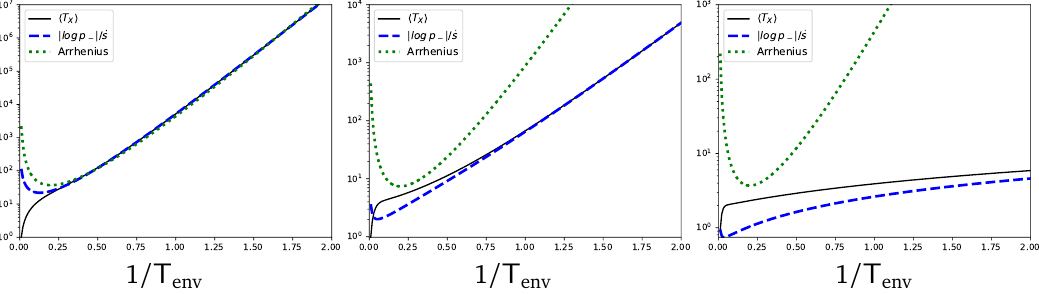
Figure 3: Asymptotic lower bound on the mean first-passage time. The ratio 〈 T 〉 ˙ s / | log p | is plotted as a function of (cid:96)/δ , where T − X Eq. (2) of the nonequilibrium Kramer process X described by Eq. (61) with triangu- lar potential u given by Eq. (62). Curves shown are for the parameters δ = 5, x ∗ = 1, = 10, T = 1, and γ = 1, and the values of f are given in the figure legend. u 0 env